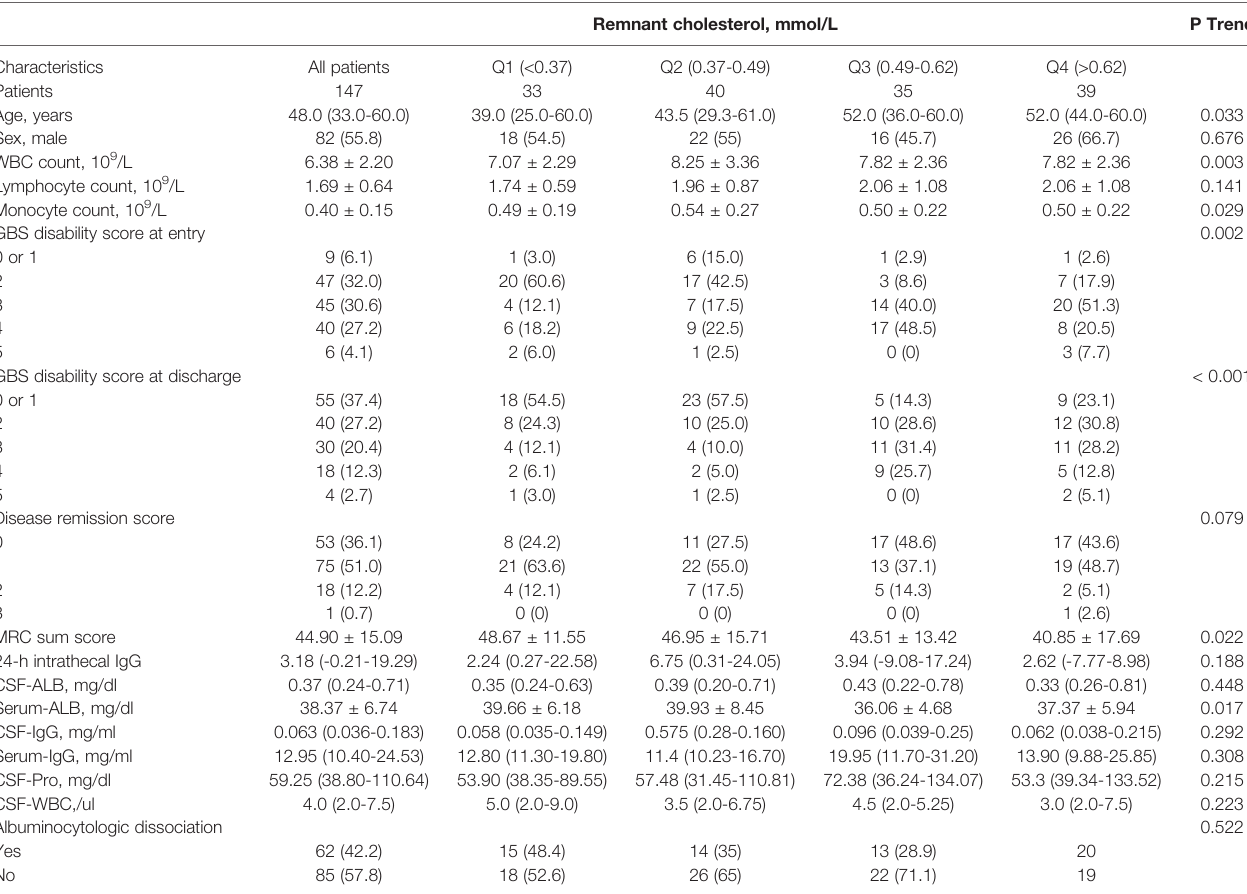
Remnant cholesterol, mmol/L P Trend